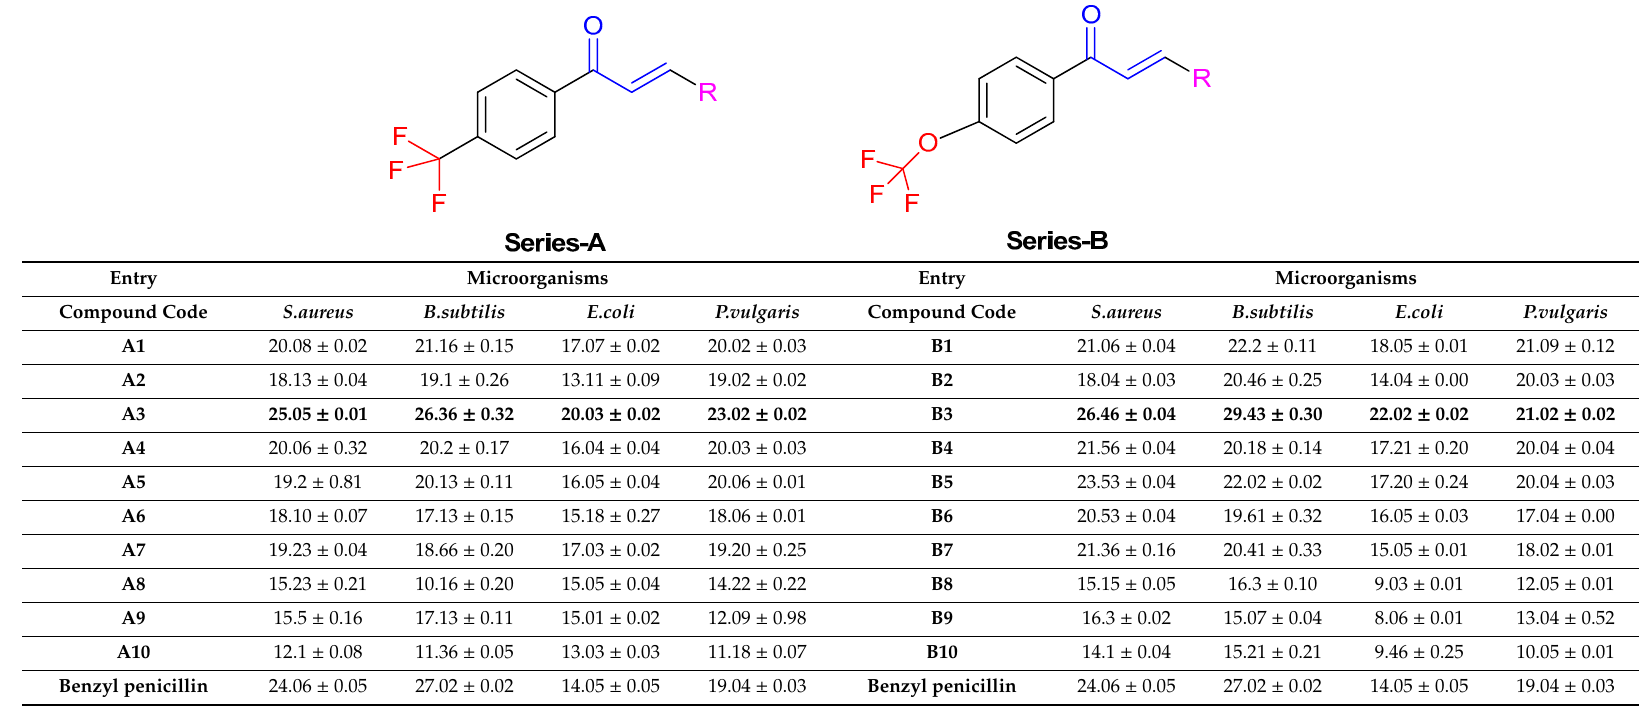
Table 1. Antibacterial (zone of inhibition in mm) a, b of trifluoromethyl and trifluoromethoxy substituted chalcone derivatives (A1–A10 and B1–B10).